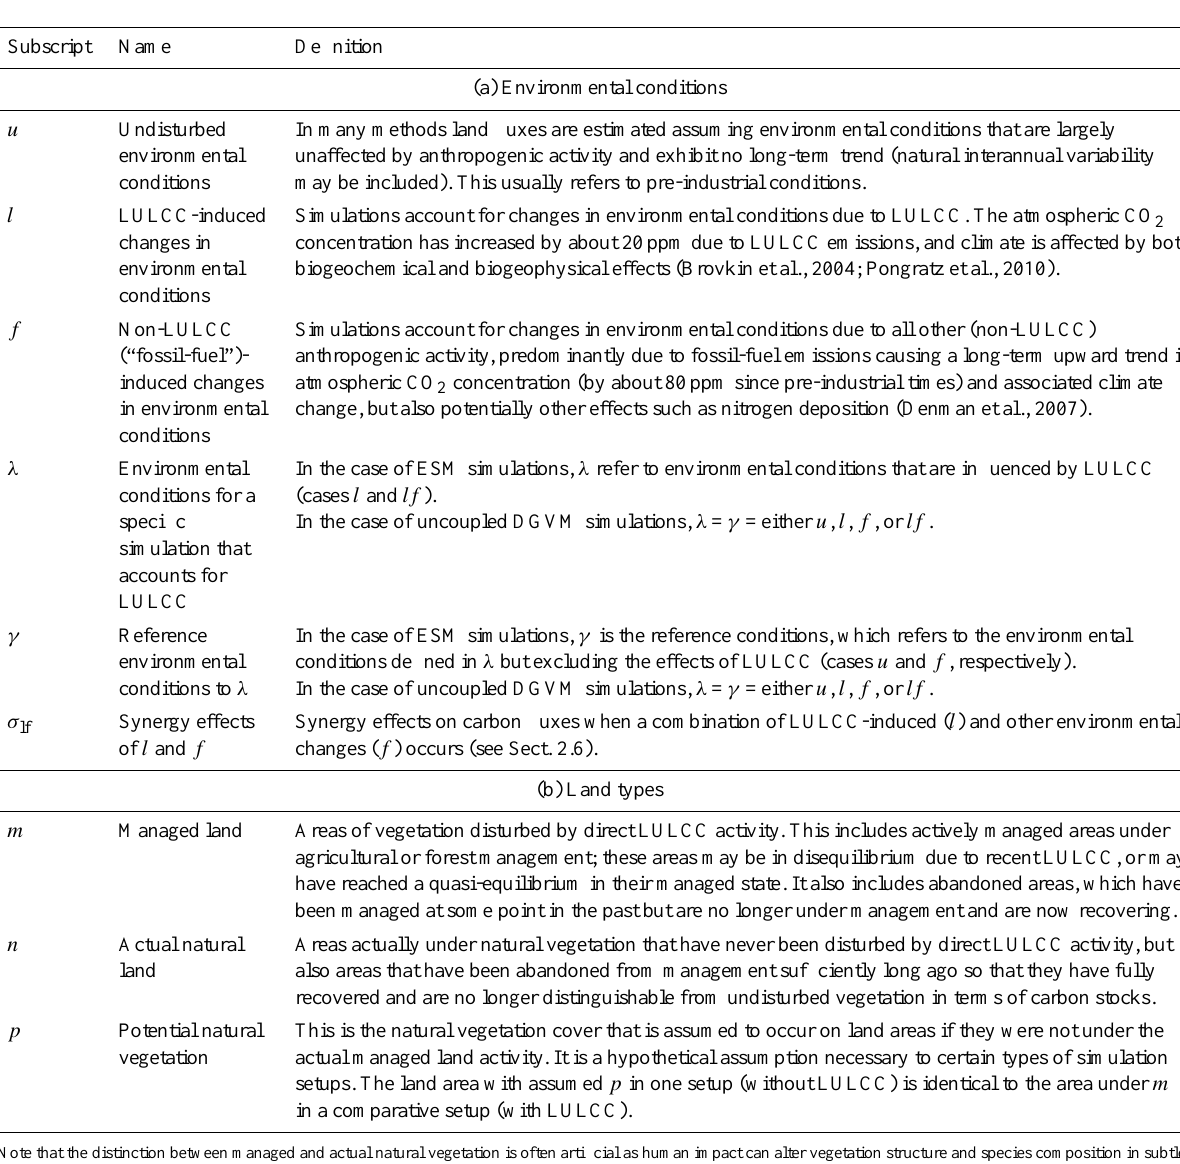
Table 2. Definitions of land types and environmental conditions needed to distinguish the different methods to estimate the net LULCC flux ∗